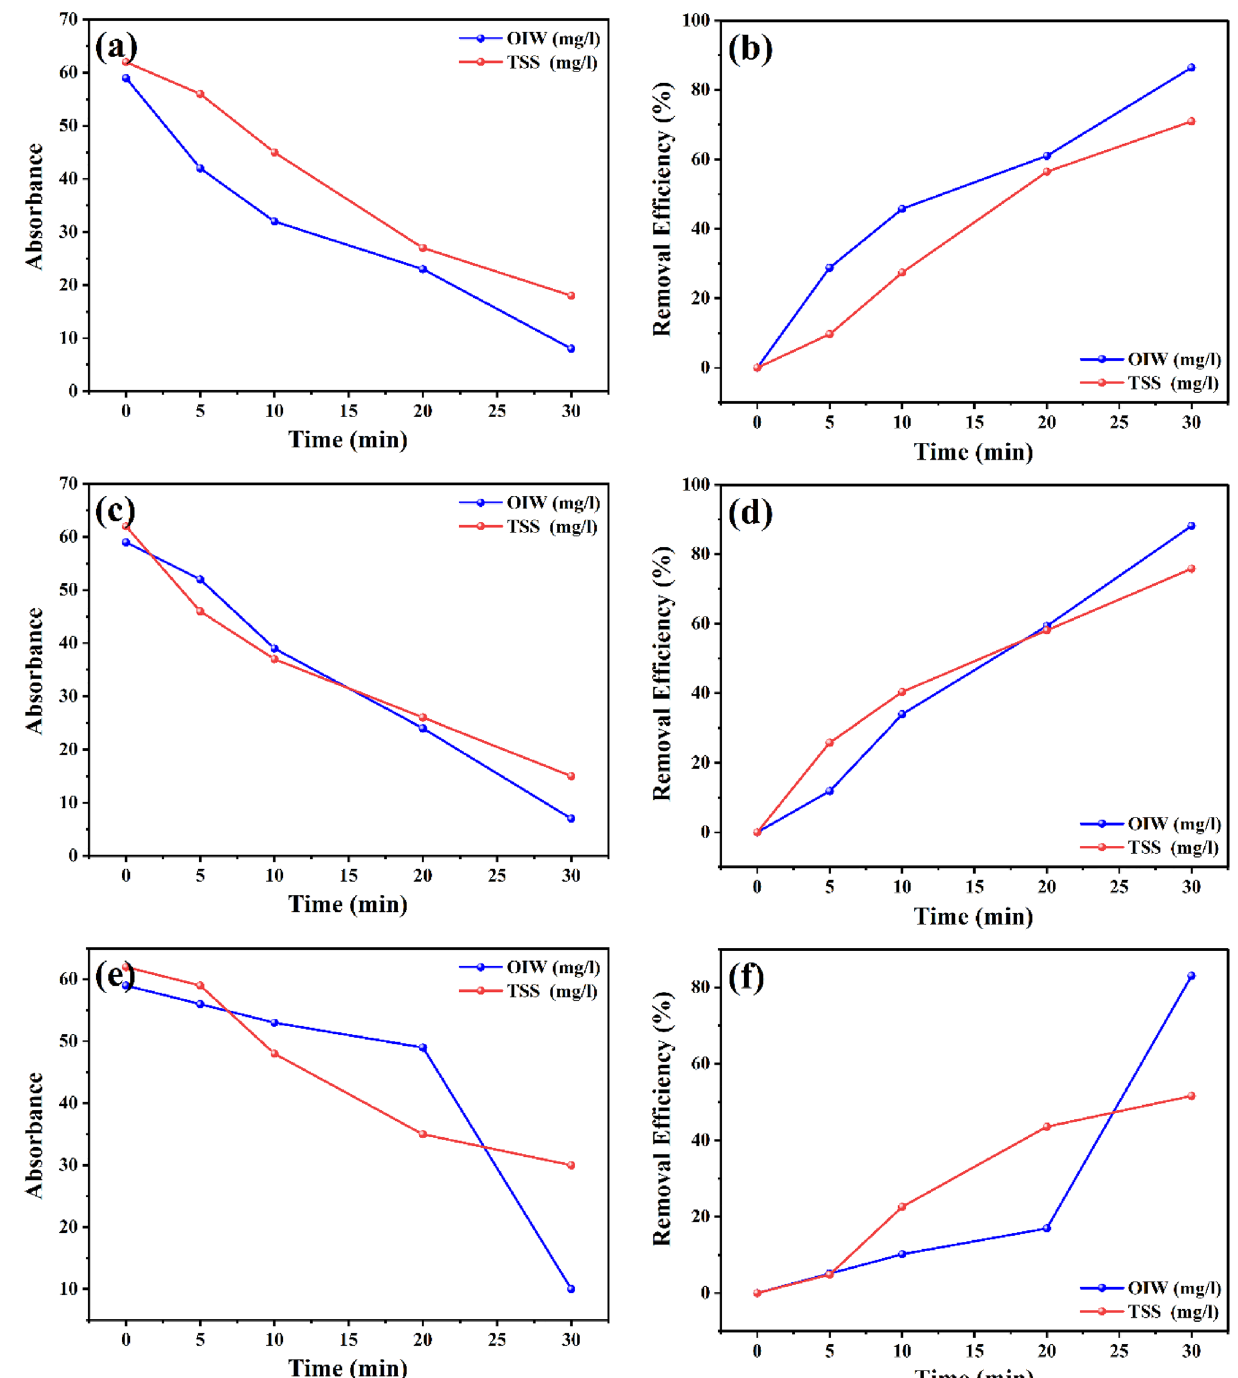
Figure 8. The photo-degradation rate hydrocarbon in oily water (OIW) and removing of Total Suspended Solids